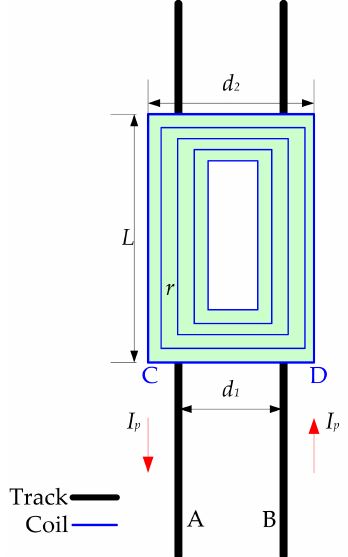
Figure 5. Magnetic field coupling model for RGV application.